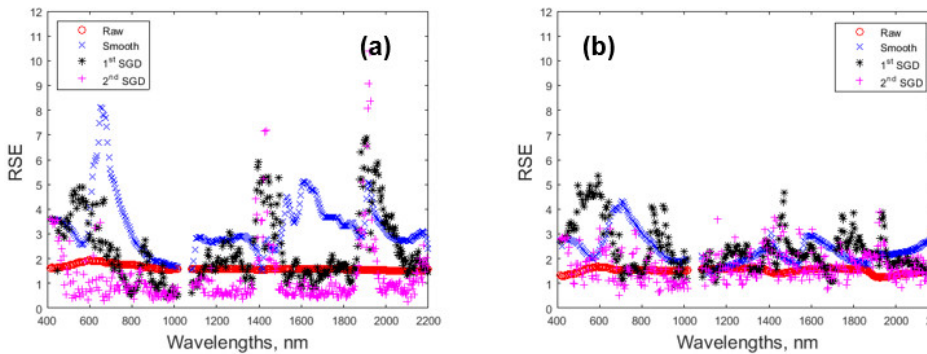
Figure 7. RSE estimates for soil spectra and their derivatives (ex situ ( a ) in situ ( b )). Table 2. Ratio of spread over error (RSE) comparison.